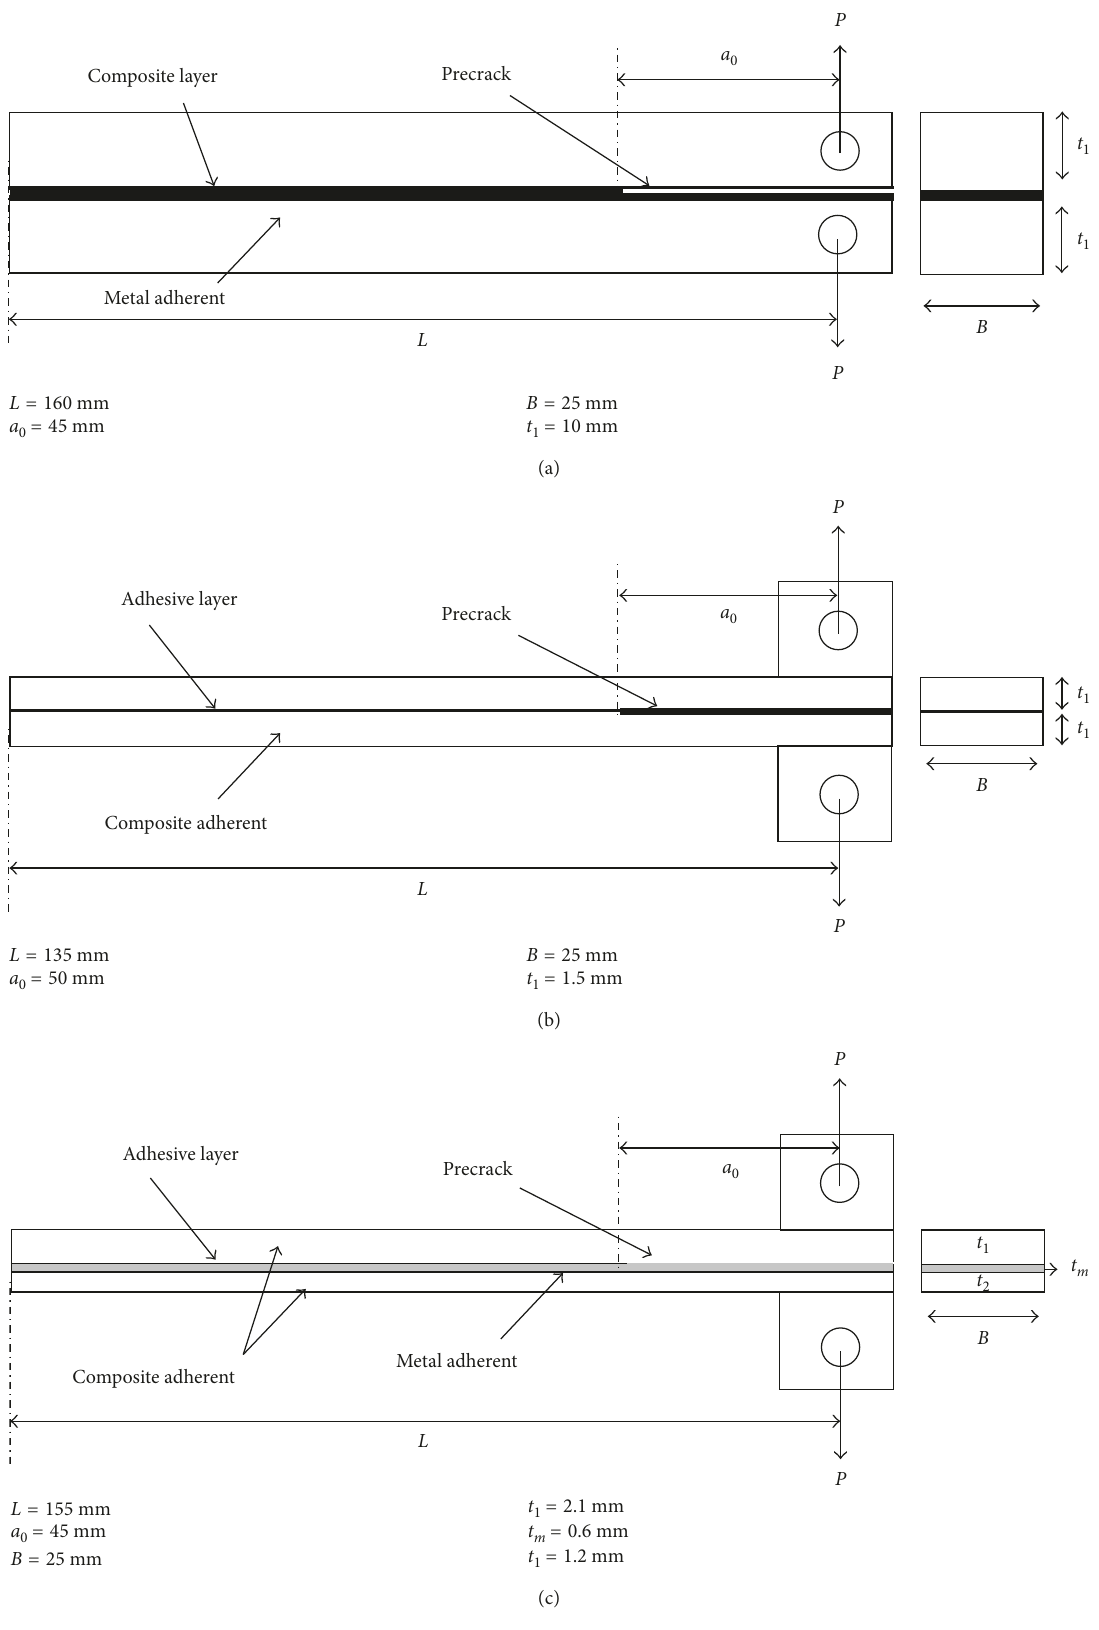
Figure 1: Schematic representation of DCB geometry: (a) M-C-M configuration, (b) C-C configuration, and (c) C-M-C